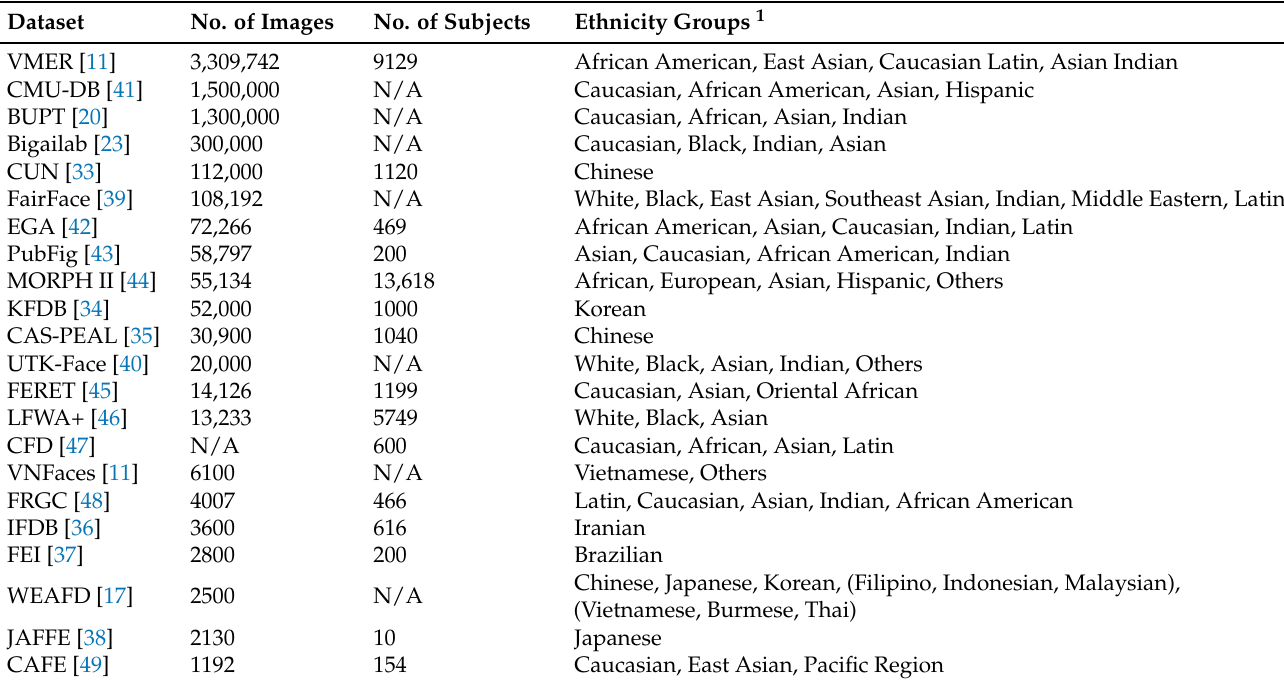
Table 4. Overview of ethnicity classification